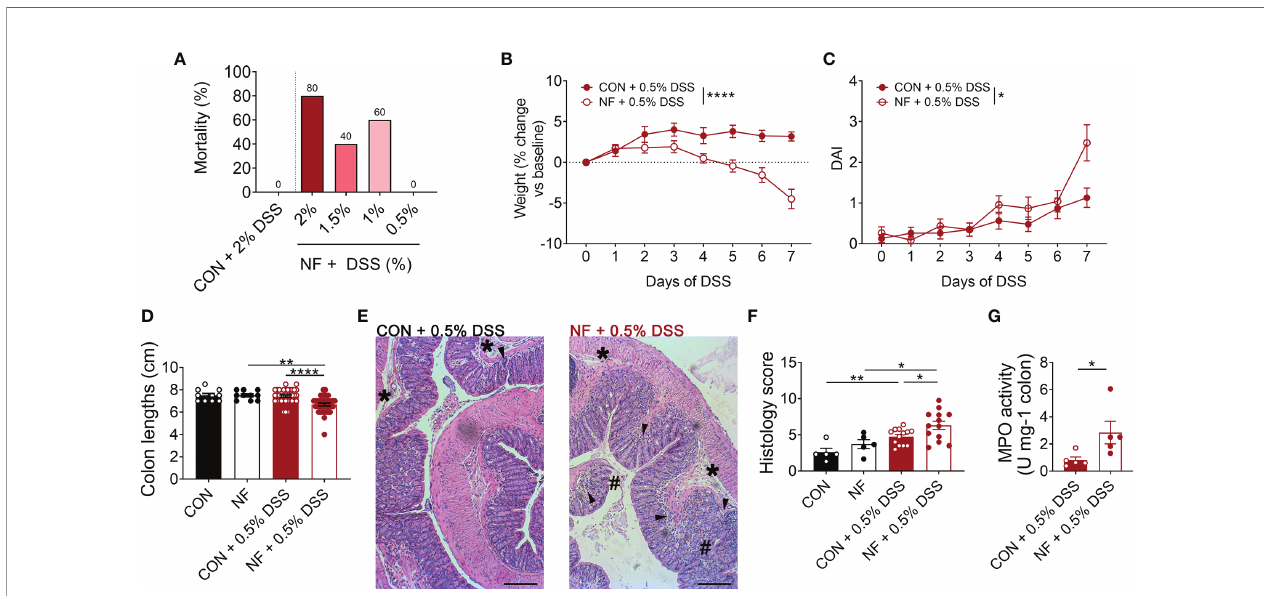
FIGURE 4 | No- fi ber diet exacerbates DSS-induced colitis. WT mice were fed either a control (CON) or no fi bre (NF) diet for 14 days prior to and during DSS administration. (A) Mortality rate (%) at day 7 following 0.5, 1, 1.5, or 2% DSS added to drinking water (N = 5 per group). During 0.5% DSS-induced colitis, there was daily monitoring of (B) weight (N = 23 per group) and (C) DAI (N = 23 per group). (D) At day 7 of 0.5% DSS-induced colitis, mice were culled, and colon length was measured (N ≥ 10 per group). (E) The colon was fi xed, and histological sections were stained using hematoxylin and eosin. Scale bar = 400 µm. (F) Tissues were blindly scored for parameters assessing tissue involvement, in fl ammation (arrowhead), edema (*), and epithelial damage (#) (N ≥ 5 per group). (G) In separate experiments, MPO activity of isolated colons were quanti fi ed relative to mice fed a CON diet and administered with DSS (N ≥ 5 per group). Data displayed as mean ± SEM. Two-way ANOVA was performed for all data across all time point for (B, C) , Student ’ s t -test was performed for (D, F, G) , * P < 0.05, ** P < 0.01, **** P <